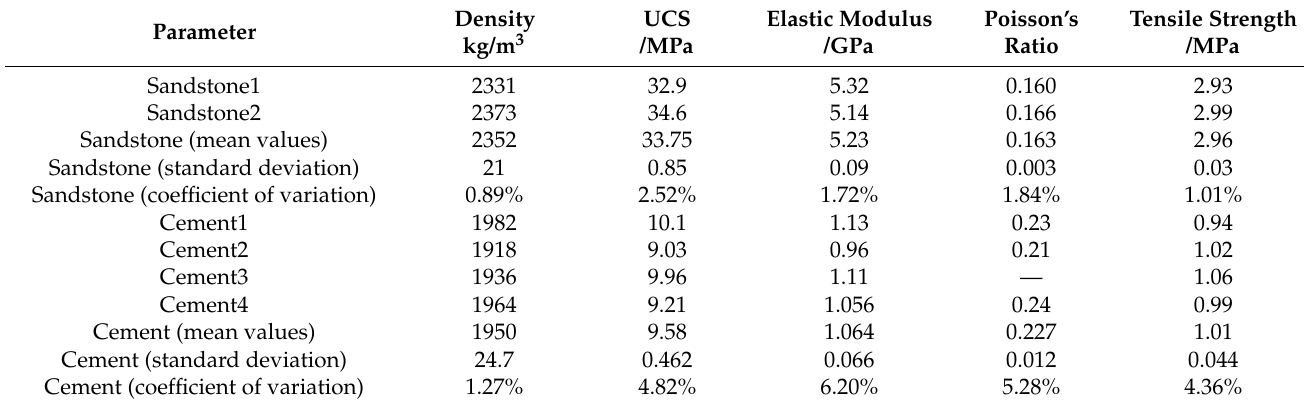
Table 1. Parameters of white sandstone and cement in this study.